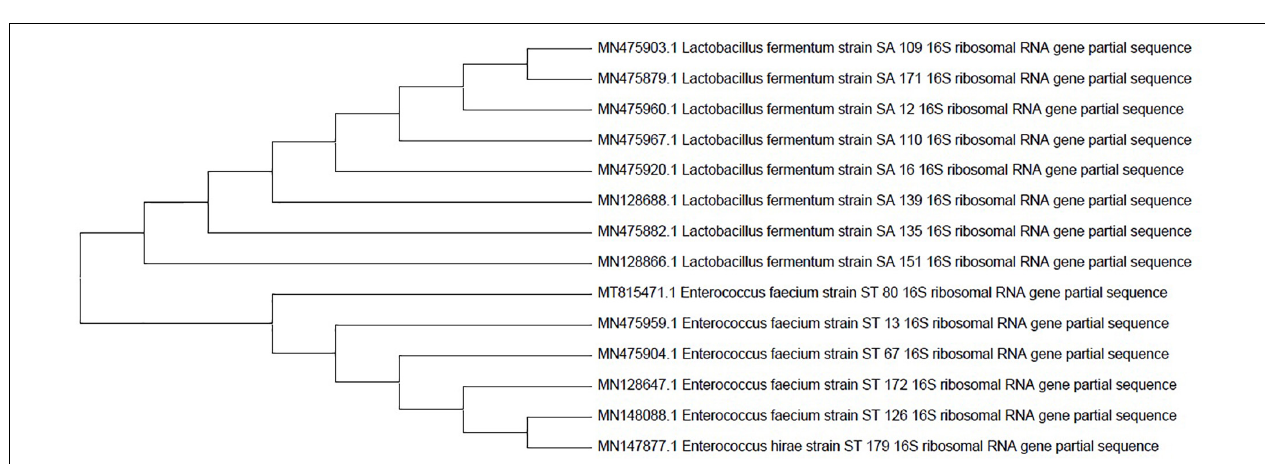
Frontiers in Microbiology |